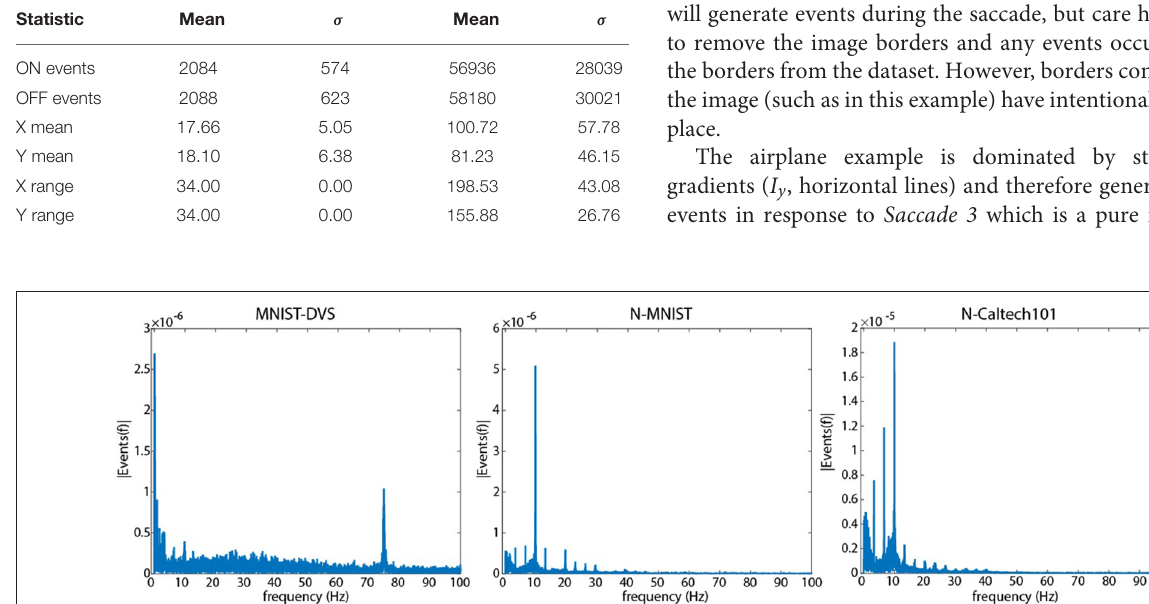
FIGURE 4 | A Fourier analysis showing the frequency at which events are elicited during recording for each dataset created using the method described in Section 2.1. The leftmost figure is a repeat of Figure 1 showing MNIST-DVS with a peak at 75Hz. The middle and right show the N-MNIST and N-Caltech101 datasets, respectively. The two rightmost examples show no peak at 75Hz. They have a strong 10Hz peak due to the 10,Hz frequency of saccades (100ms each), and a strong peak at 3.3Hz due to the length of each recording (300ms). Harmonics of 3.3 and 10Hz can also be seen. A similar 150Hz harmonic exists in the MNIST-DVS data but is not shown in order to improve visibility for lower